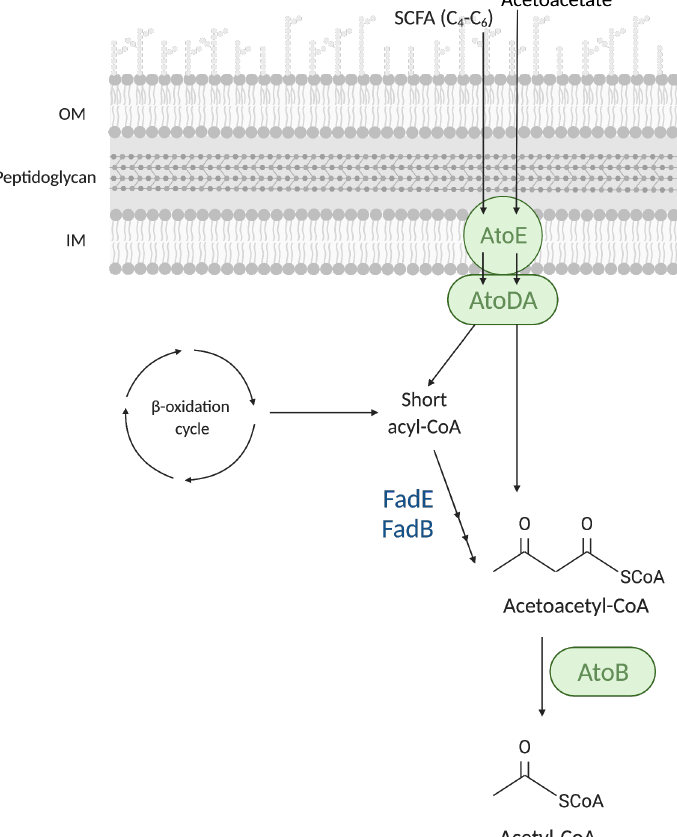
Figure 7. Degradation of short-chain fatty acids (SFCAs). AtoE is an inner membrane (IM) protein predicted to have ten transmembrane domains [43] involved in the import of SCFAs and acetoacetate across the IM. AtoD and AtoA are the α - and β -subunits of the acetyl-CoA:acetoacetyl-CoA transferase that activates the SCFAs and the acetoacetate by the CoA thioesterification. The catabolism of SCFAs requires an oxidation and a hydration step carried out by FadE and FadB, respectively. The AtoB thiolase II is in charge of the last thiolytic cleavage of the acetoacetyl-CoA to acetyl-CoA. The Ato enzymes specifically involved in the SCFA catabolism are shown in green capsules. FadE and FadB are indicated in blue.